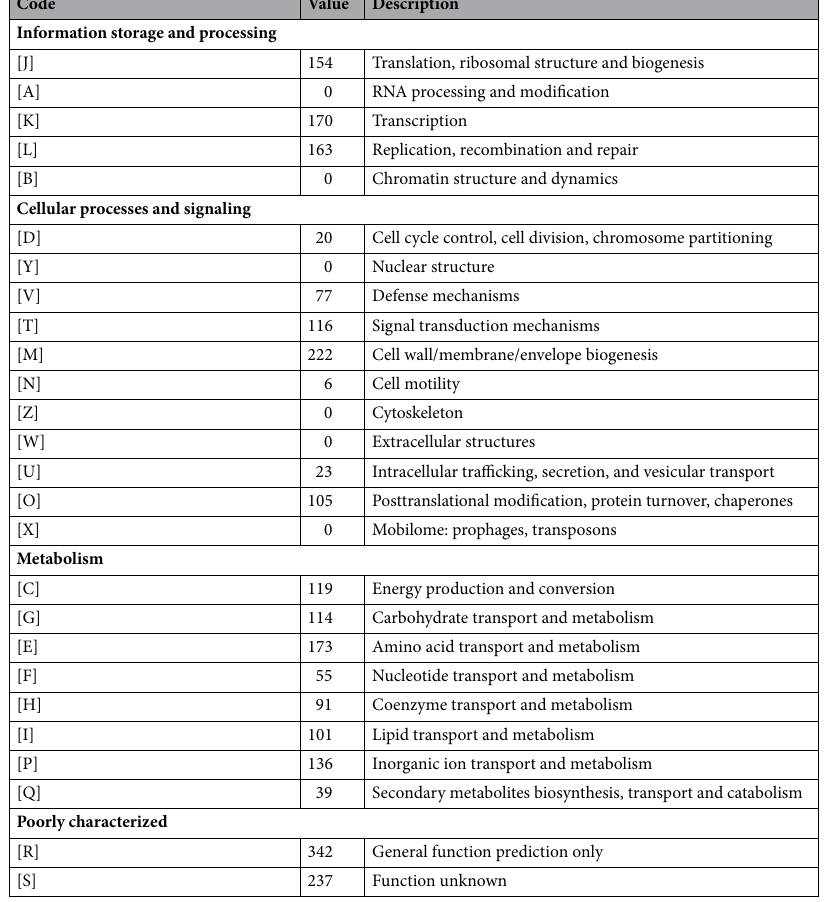
Table 4. Functional annotation of predicted genes according to the COGs. Functional annotation of Marseille-P9602 predicted genes according to the COGs database.